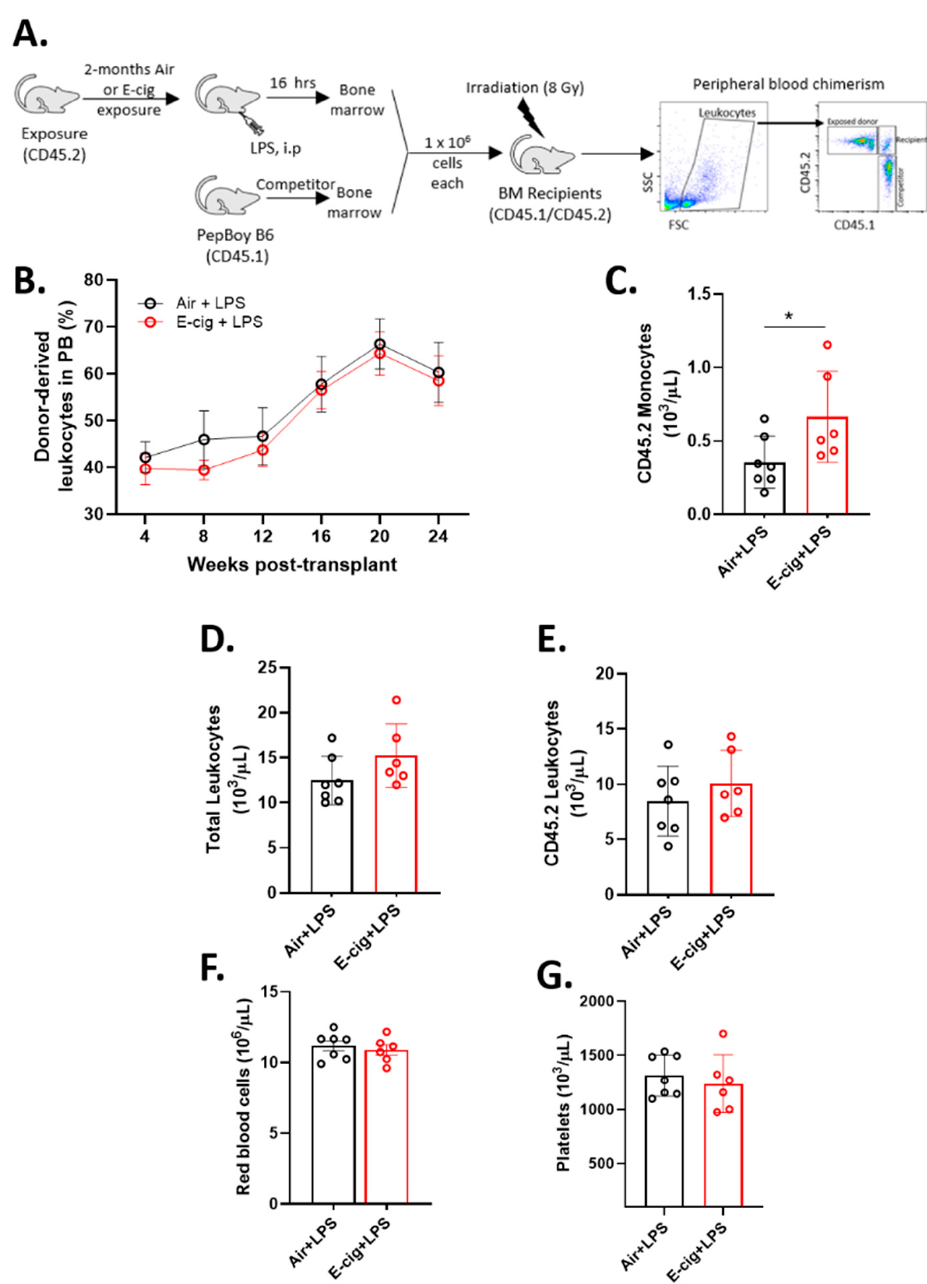
Figure 5. Systemic LPS post-E-cigarette exposure results in persistent monocytosis. ( A ) Experimental design. ( B ) Peripheral blood chimerism of CD45.2 leukocytes from air and E-cigarette exposed donor cells. Peripheral blood counts of ( C ) CD45.2 monocytes, ( D ) leukocytes, ( E ) CD45.2 leukocytes, ( F ) red blood cells, and ( G ) platelets 20 weeks post-transplant. Data are shown as mean ± SEM. n = 5–6 mice / group. * p < 0.05, unpaired student’s t -test .